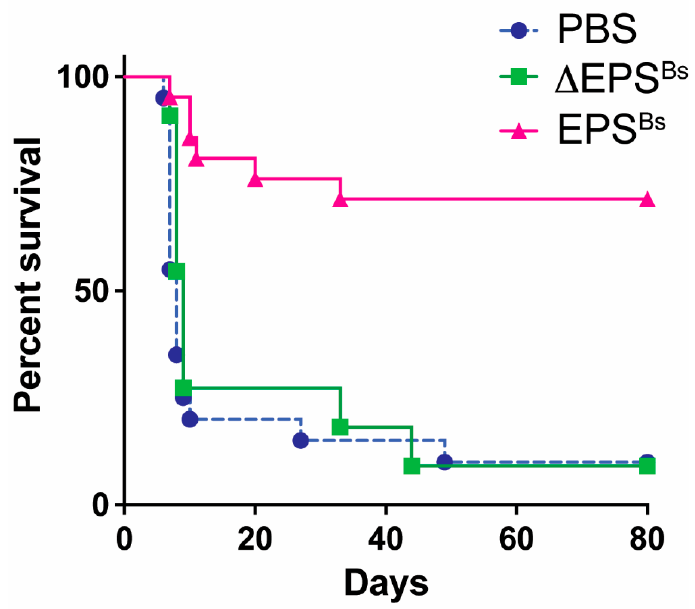
Figure 2. Kaplan–Meier survival curves of mice undergoing acute graft versus host disease (GvHD) after treatment with B. subtilis exopolysaccharide (EPS Bs ), or the negative control Δ EPS Bs . Δ EPS Bs is purified from a B. subtilis mutant epsH , which does not produce EPS associated with biofilms. Adapted from [7].